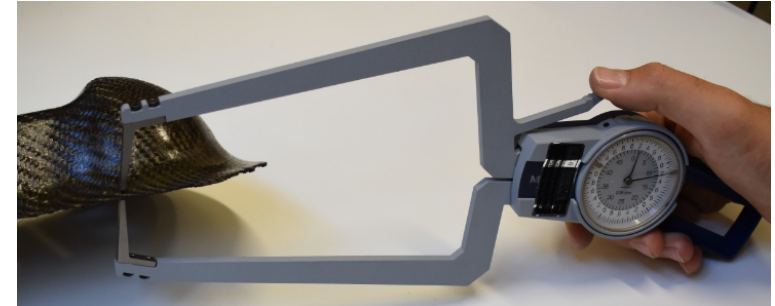
Figure 12. Experimental measurement of wall thickness for GF/PP Double Dome.